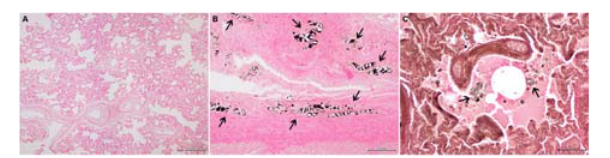
FIGURE 1 | Lung sections treated with OsO 4 . (A) Appearance of a lung parenchyma negative to fat emboli (Bar = 500 µ m). (B) Black-stained adipocytes in the pleura (arrows) (Bar = 200 µ m). (C) Black-stained fat droplets within a bronchiole (arrows) (Bar = 200 µ m).